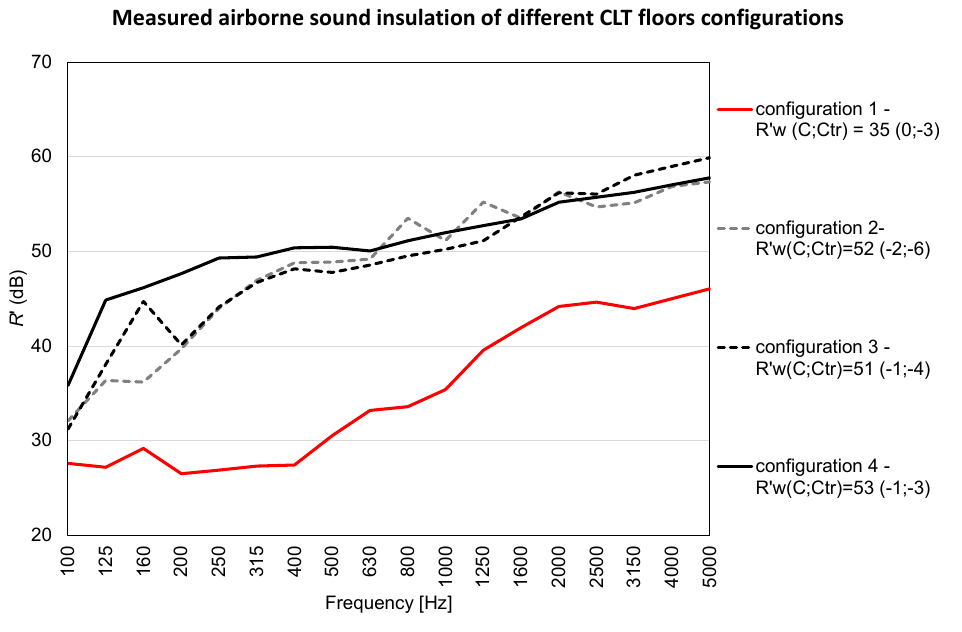
Figure 14. Airborne sound insulation for CLT floors (configurations 1, 2, 3, and 4).